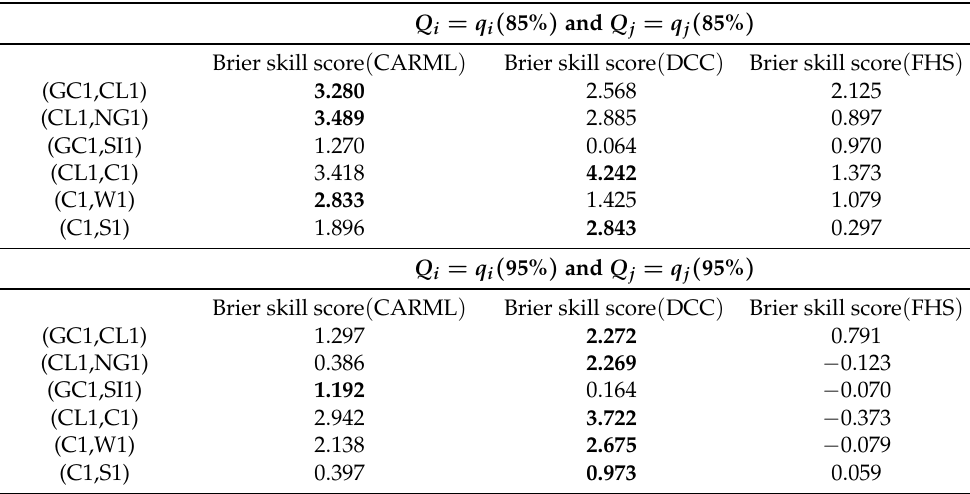
Table 5. Brier skill scores for the selected pairs of